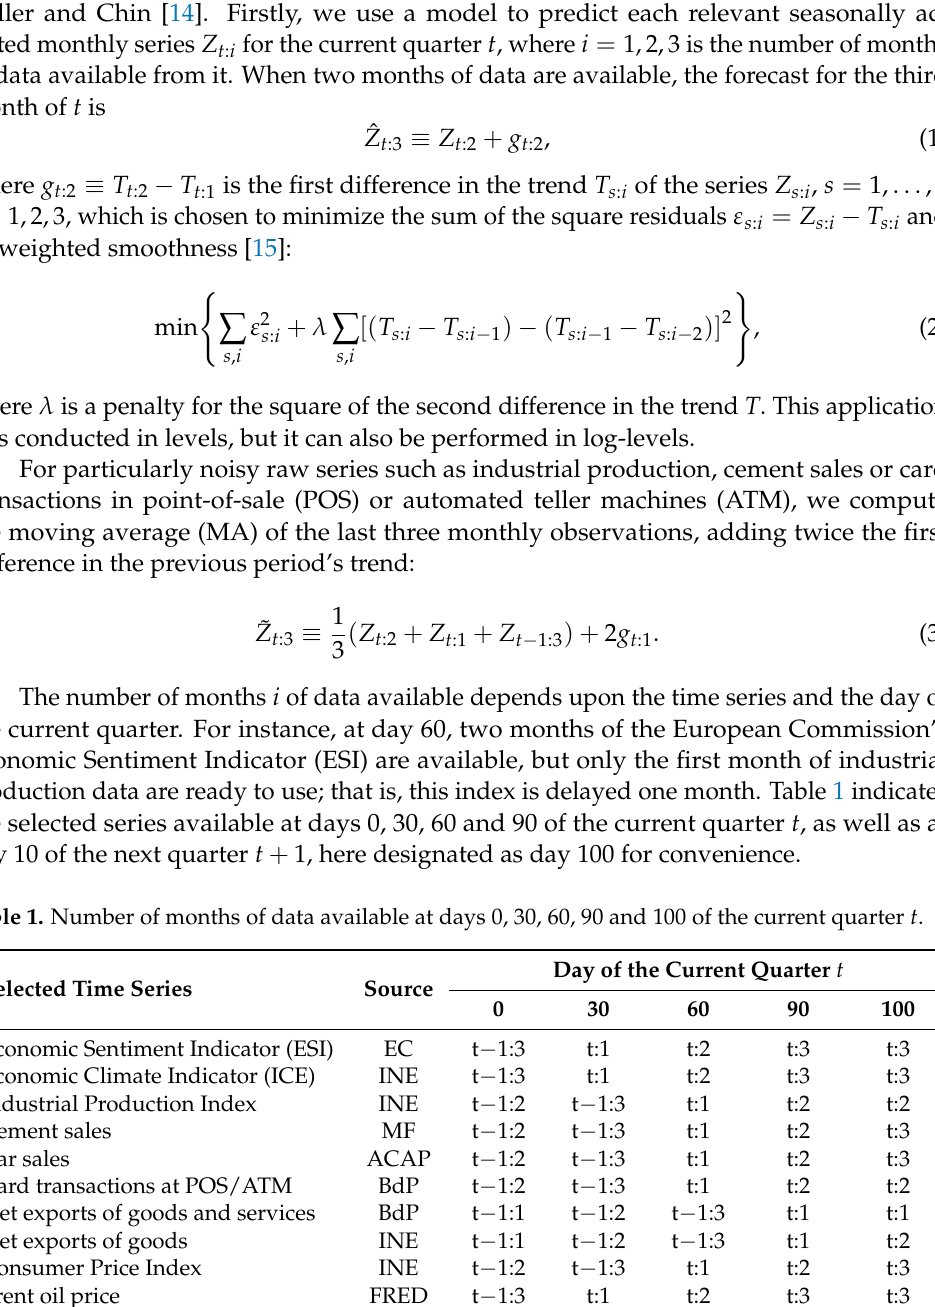
Day of the Current Quarter t